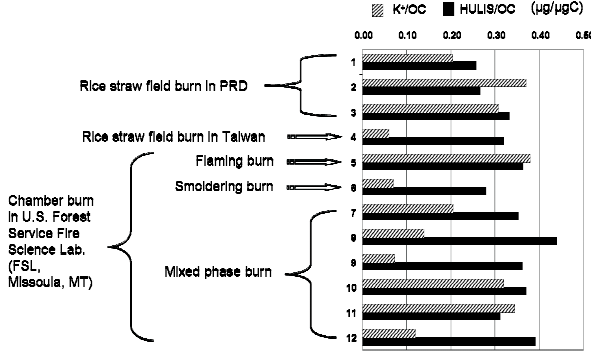
Fig. 1. HULIS and K + emissions normalized by OC concentra- tions in different rice straw burning samples. The OC data were determined by the TOT method except those from rice straw field burn in Taiwan (No. 4), which were obtained by the TOR (ther- mal/optical reflectance)